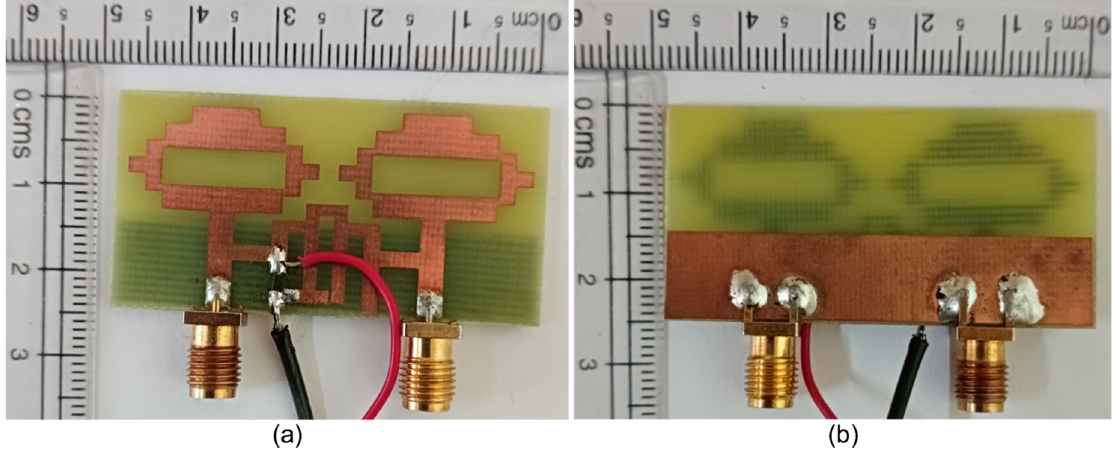
Figure 24. Reconfigurable two-port MIMO antenna prototype: ( a ) top view and ( b ) bottom view.